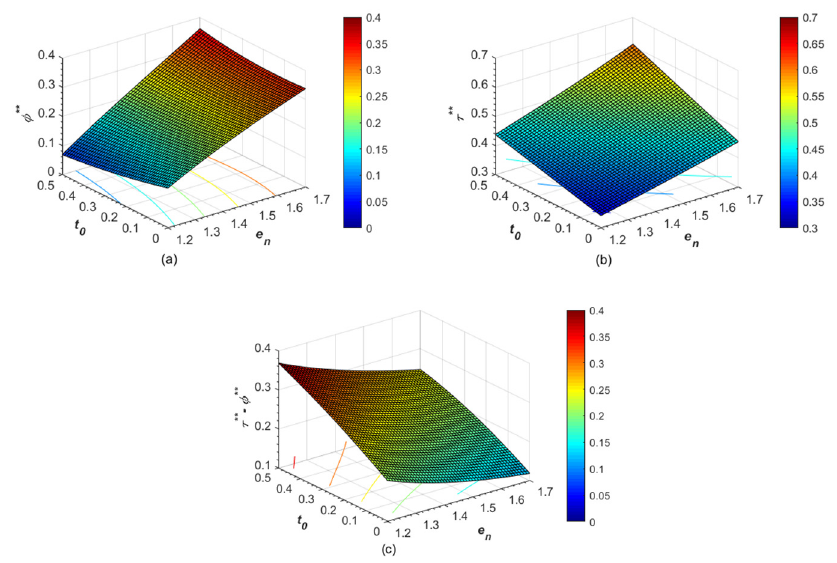
Figure 2. Effects of e n and t 0 on ( a ) optimal pre-determined abatement target φ **, ( b ) carbon abatement investment level τ **, and ( c ) excessive abatement level τ ** − φ **.